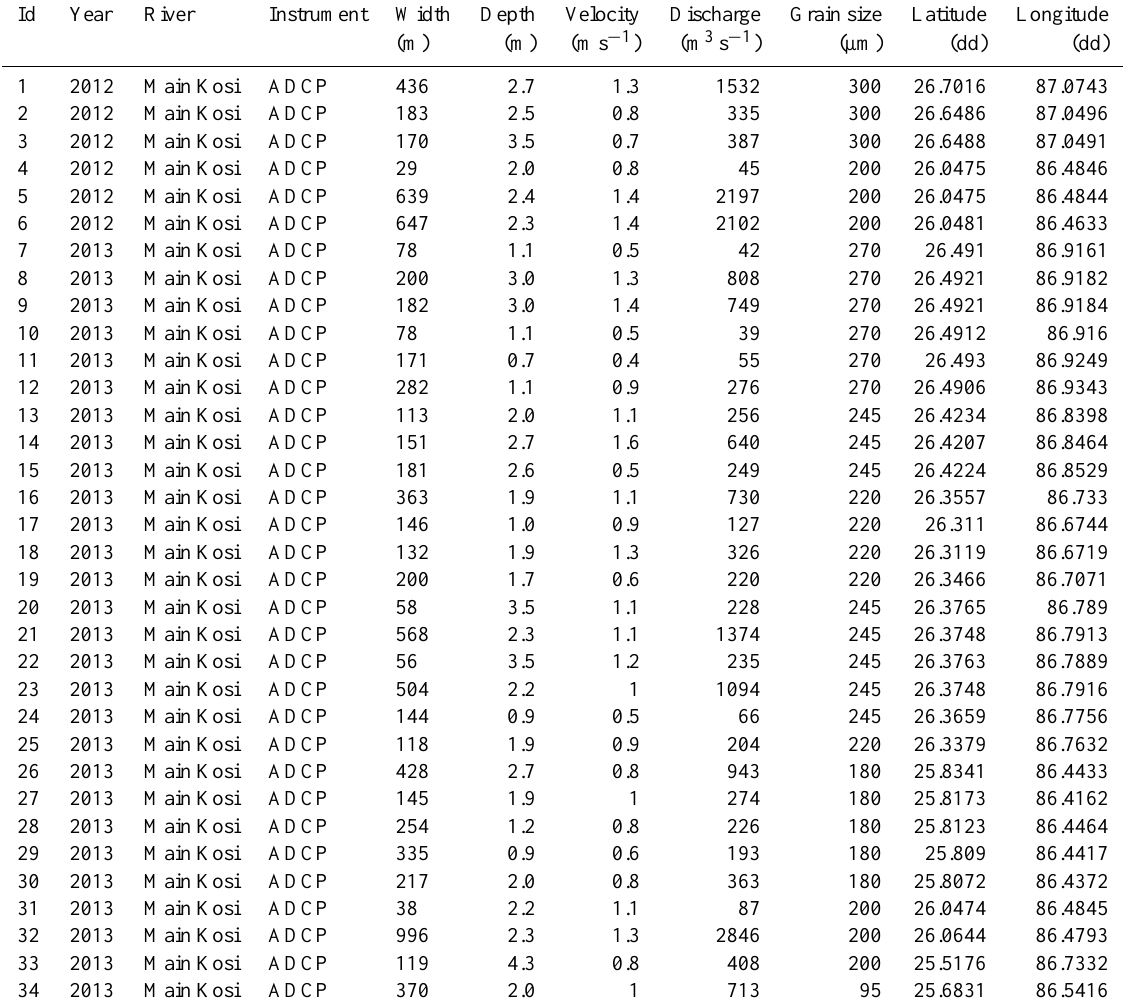
Table 2. Hydraulic geometry and water discharge data measured on threads of braided